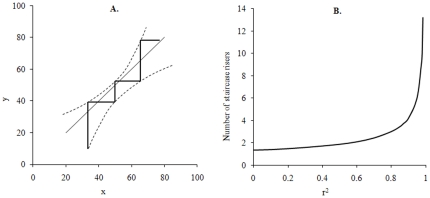
Prairie's staircase, suggesting a non-linear relationship between the correlation coefficient (r2) and predictive power.A. The creation of staircase risers from the 95% confidence limits of a correlation. B. The r2 value of correlations and the number of obtained staircase risers. From [8].